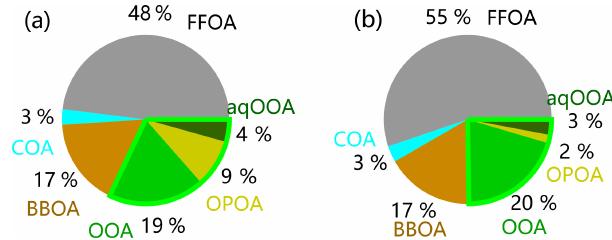
Figure 12. Average contributions of OA sources to BrC absorption at ground level from (a) a linear regression model, and (b) positive matrix factorization (Fig. S9). The sources of OA include fossil- fuel-related OA (FFOA), cooking OA (COA), biomass burning OA (BBOA), oxygenated OA (OOA), oxidized primary OA (OPOA), and aqueous-phase OOA (aq-OOA) (Xu et al.,